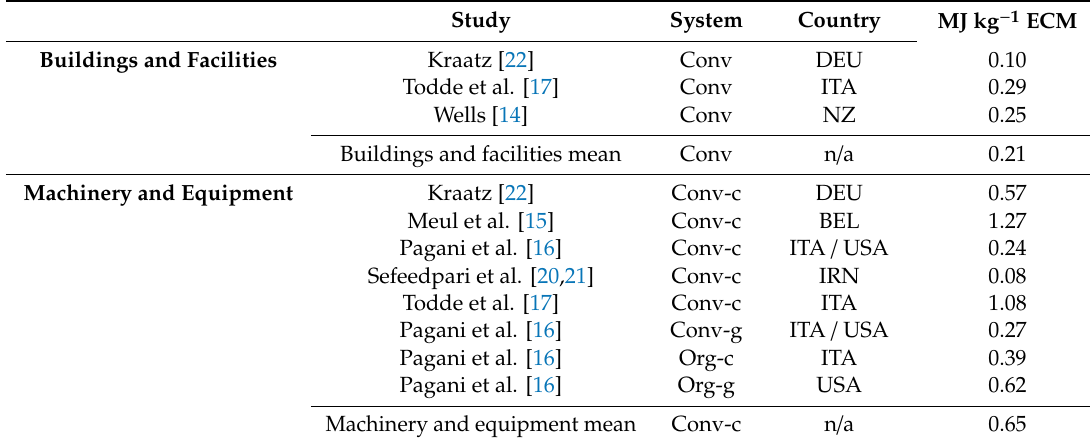
Table 3. Embodied energy values found in